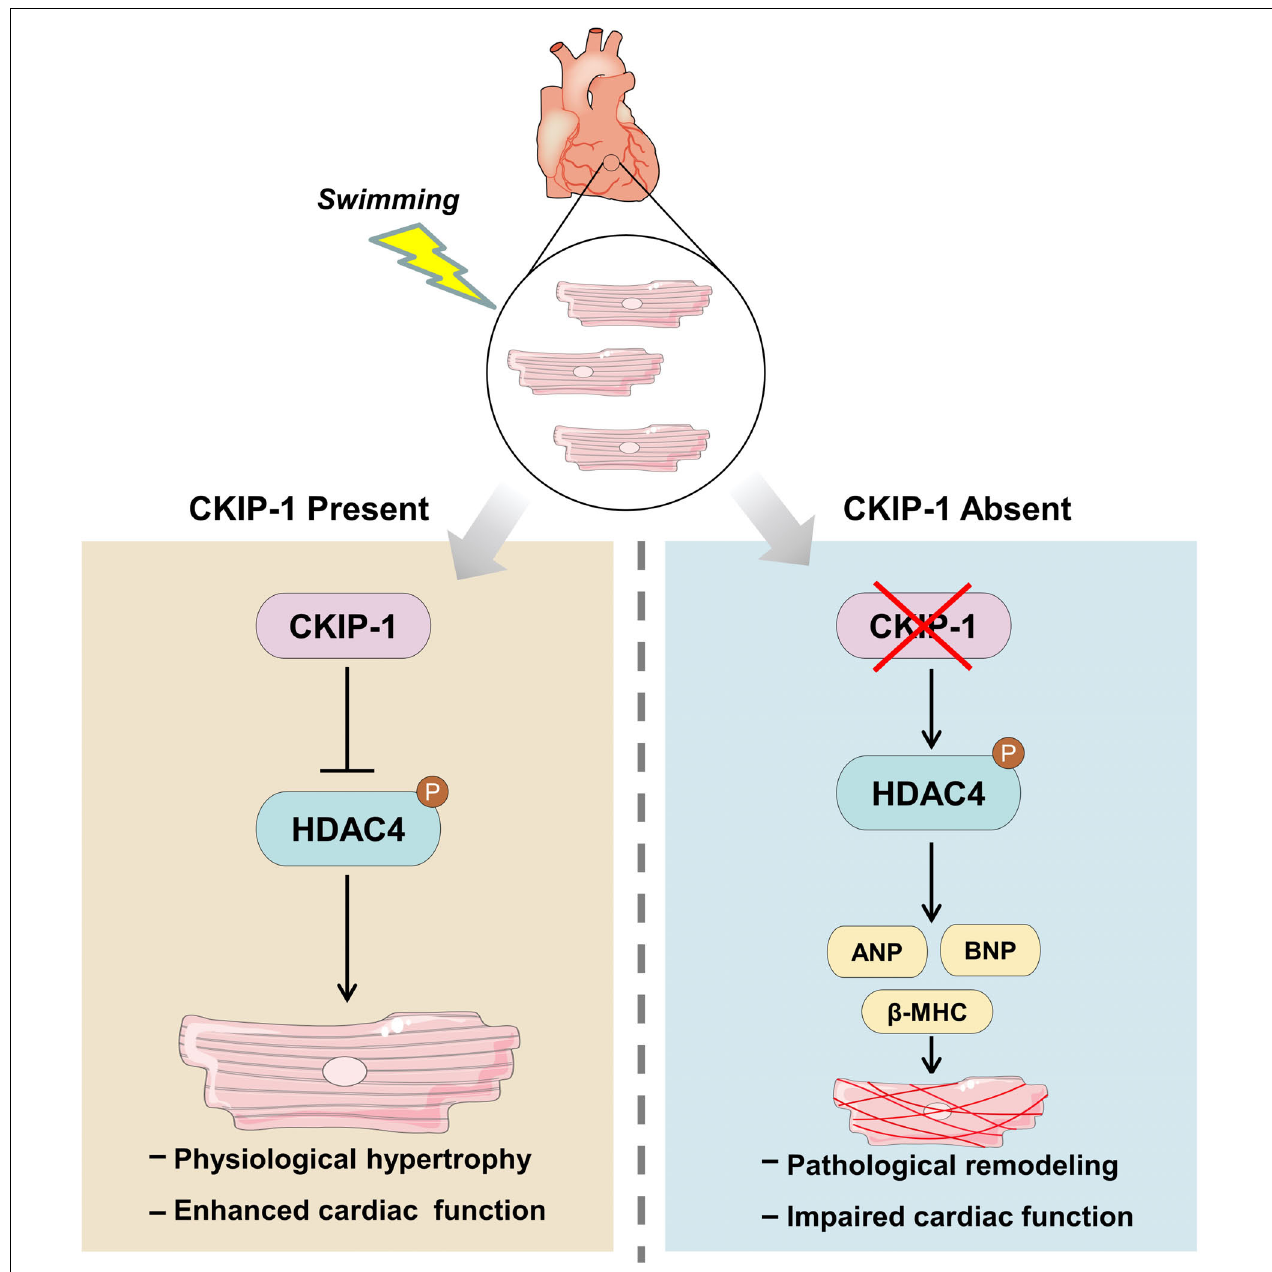
FIGURE 6 | Model for the mechanism of CKIP-1 regulation of cardiac remodeling by inhibition of HDAC4 phosphorylation during